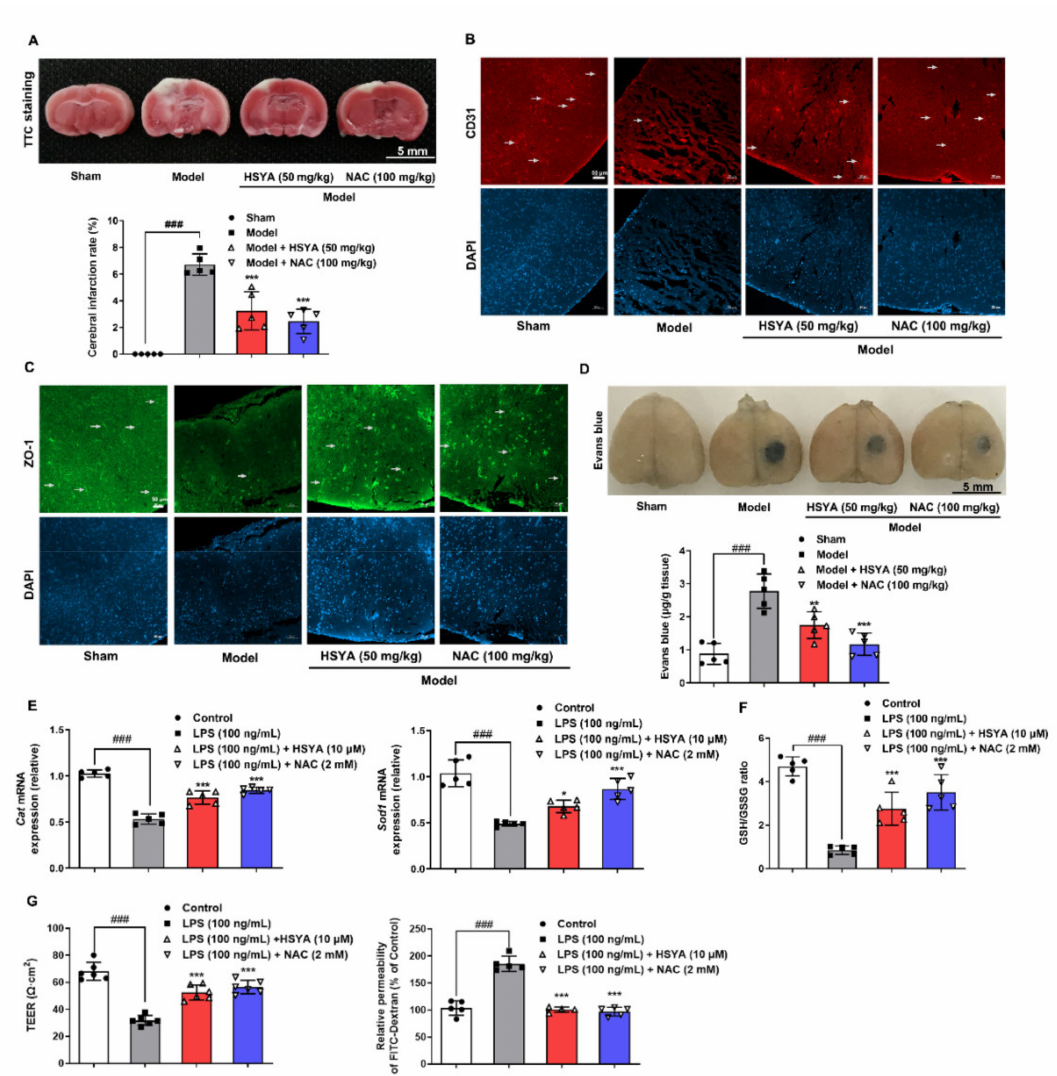
Figure 1. HSYA protected brain microvessels against ischemic injury. Mice were intraperitoneally injected with hydroxysafflor yellow A (HSYA) and NAC for 3 days after photothrombotic stroke: ( A ) the brain tissue coronal sections were stained with TTC staining, and the infarct area was counted with Image J; ( B , C ) CD31 and zonula occludens-1 (ZO-1) expressions were detected by immunofluorescence in the peri-infarct zones of brain tissue (scale bar: 50 µ m); ( D ) mice were injected with 2% Evans blue via tail vein. Brain tissue was removed and photographed, and the amount of Evans blue leaking into the brain tissue was quantified; ( E ) the mRNA levels of catalase ( Cat ) and superoxide dismutase 1 ( Sod1 ) were detected by qPCR; ( F ) the GSH/GSSG ratio was measured in the treated bEnd.3 cells; ( G ) the transendothelial electrical resistance (TEER) values and FITC-dextran paracellular permeability determination across the bEnd.3 monolayer cells. All data are presented as mean ± SD of five independent experiments. ### p < 0.001 vs. indicated group, * p < 0.05, ** p < 0.01, *** p < 0.001 vs. LPS